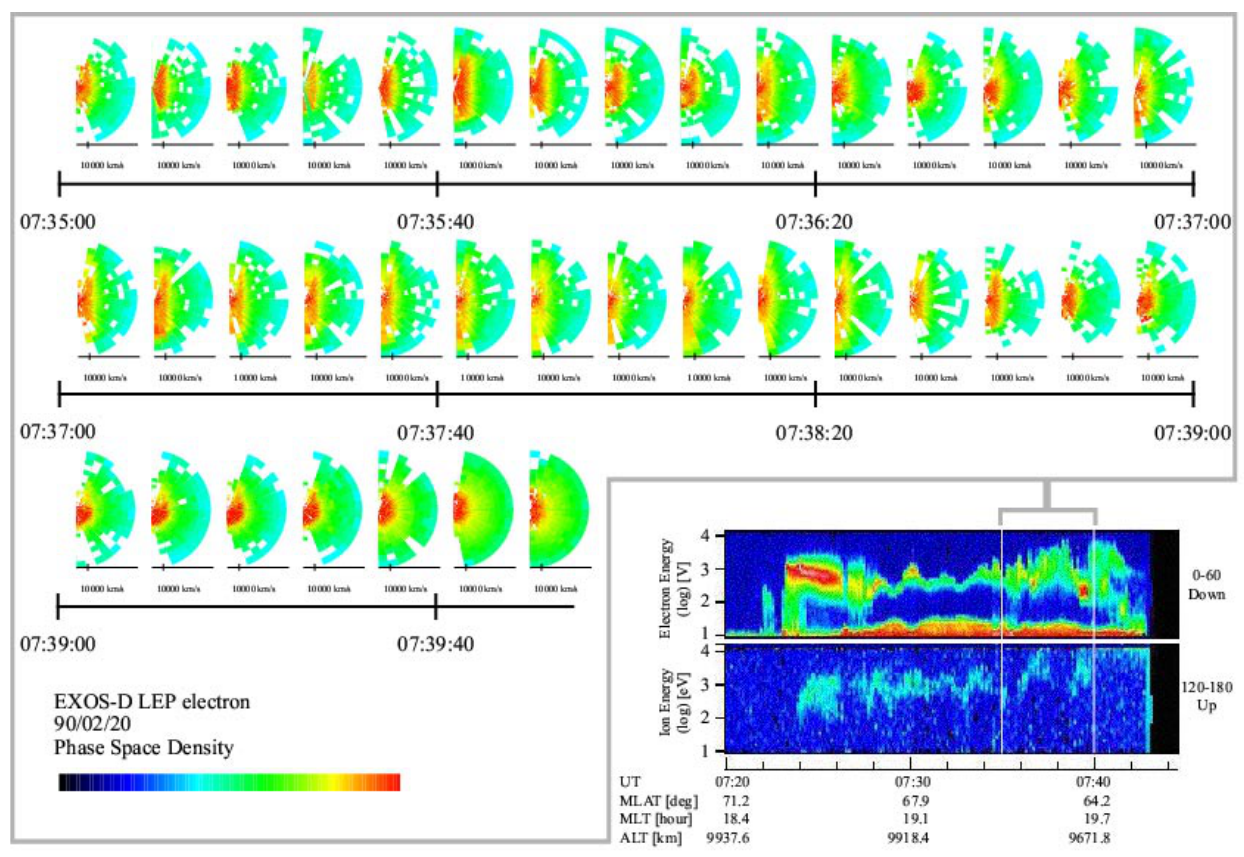
Fig. 12. The pitch angle distributions functions in the phase space obtained during 07:25 UT-07:40 UT in event 90022006. The cylindrical distributions are observed for a long time. The electrons with energies lower than E peak have contributed to the field-aligned currents during this